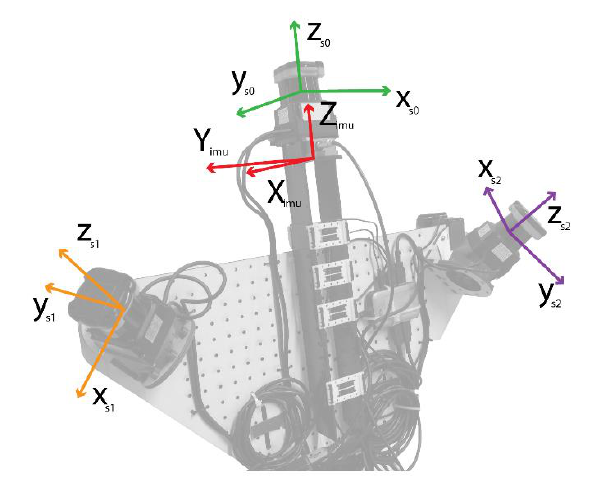
Figure 1. The backpack system with coordinate systems plotted for all four mounted sensors: the three scanners S 0 , S 1 , and S 2, and the Xsens IMU (below S 0